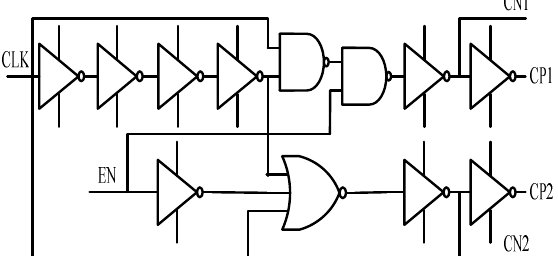
Figure 3. The structure of the bidirectional non-overlapping